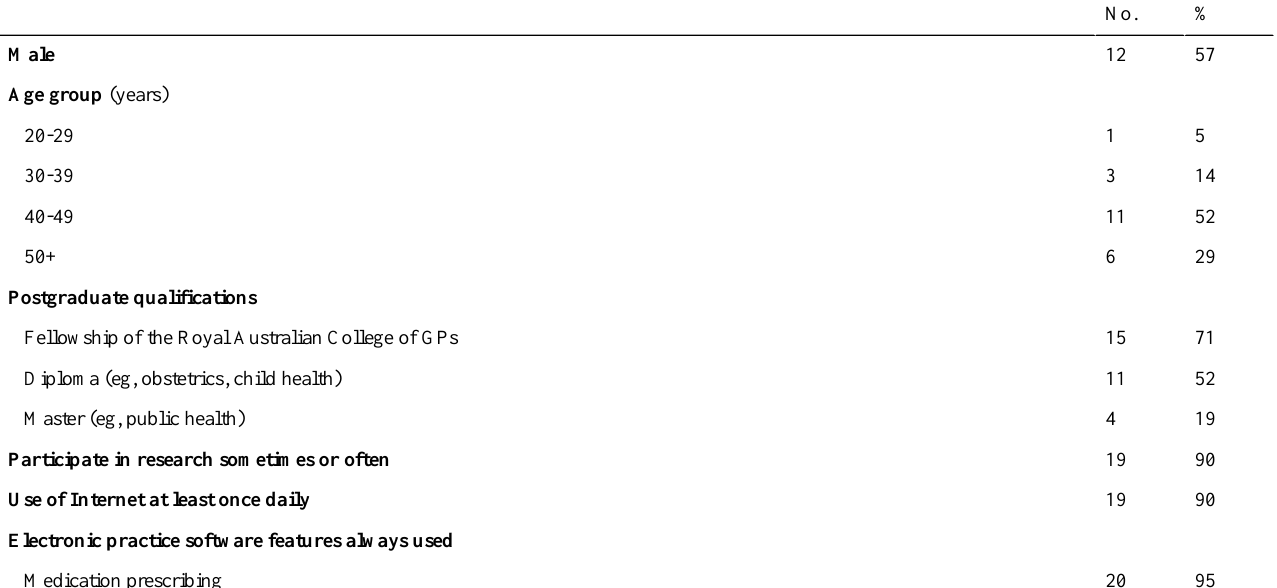
Table 1. Characteristics of the 21 participating GPs